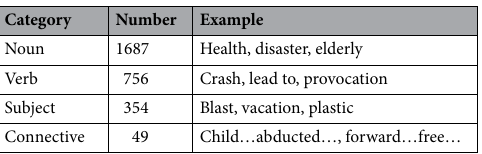
Table 1. Information about the rumor